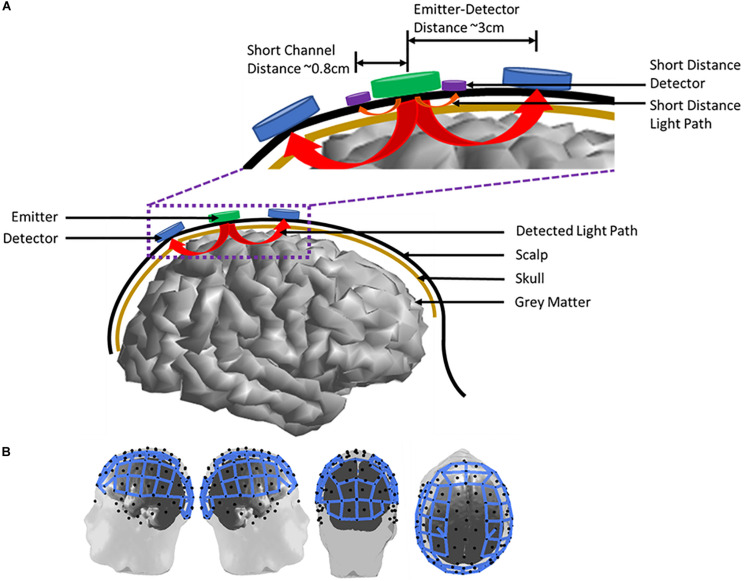
Emitter and detector arrangement on an adult human subject. (A) A two channel emitter-detector pair placement on the scalp. Arrows from the emitter to the detectors indicate the measured light path of each channel. The inset highlights emitter-detector distances and the incorporation of short-distance channels to measure scalp blood flow. (B) Full head imaging cap example on an adult human subject. Blue lines represent measurement channels (n = 102 channels) between emitter (n = 32) and detector (n = 32) pairs.